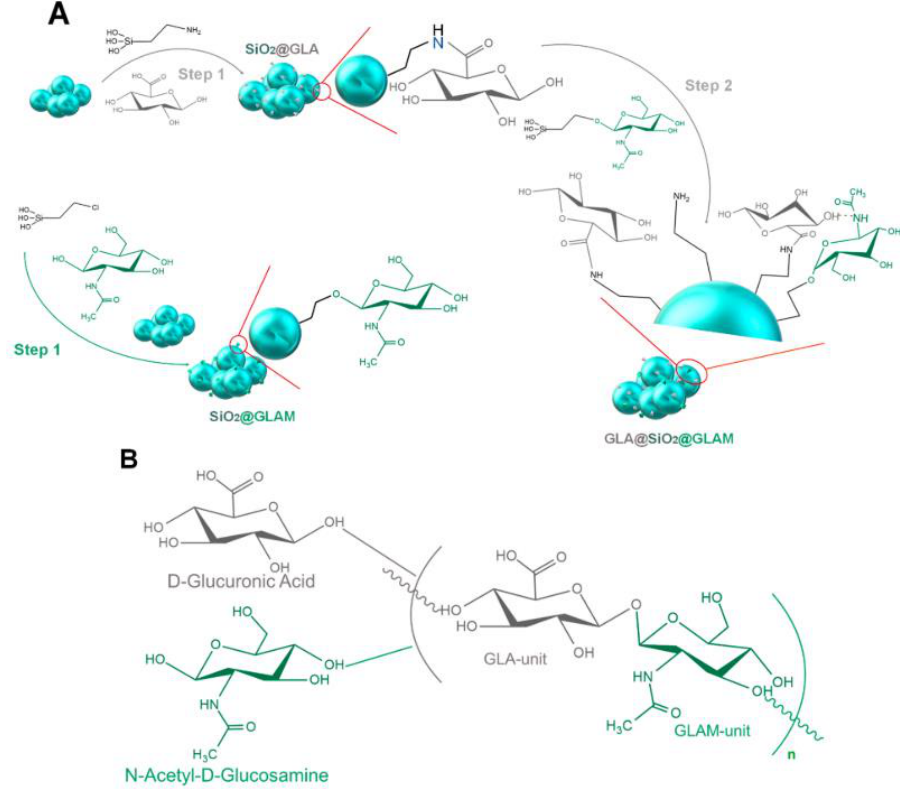
Figure 23. Schematic depiction of ( A ) the synthesis of the nanoantioxidant hybrids of covalent attached hyaluronic acid components on the surface of nanosilica, and ( B ) the structural units of hyaluronic acid, namely D-Glucuronic Acid, and N-Acetyl-D-Glucosamine. Reprinted (adapted) with permission from [15]. Copyright 2023 American Chemical